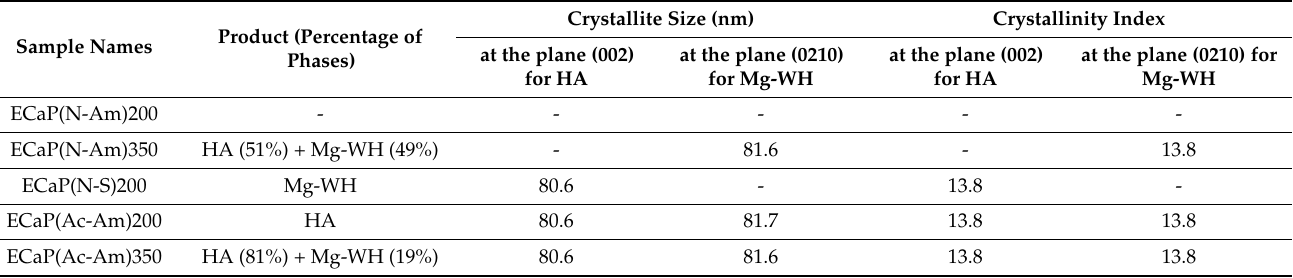
Table 6. Crystallite size and crystallinity index at (002) plane and (0210) for HA and Mg-WH, respectively, including percentage of phases of the products (for the mixed phases) of samples prepared from eggshell solution and struvite solution via a hydrothermal synthesis process at 200 and 350 ◦